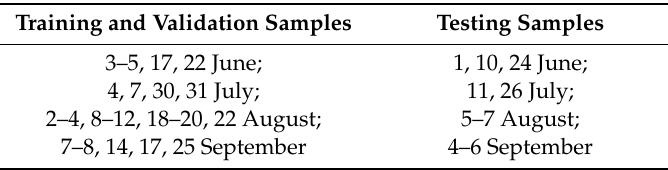
Table 3. Dates of precipitation events in training and testing